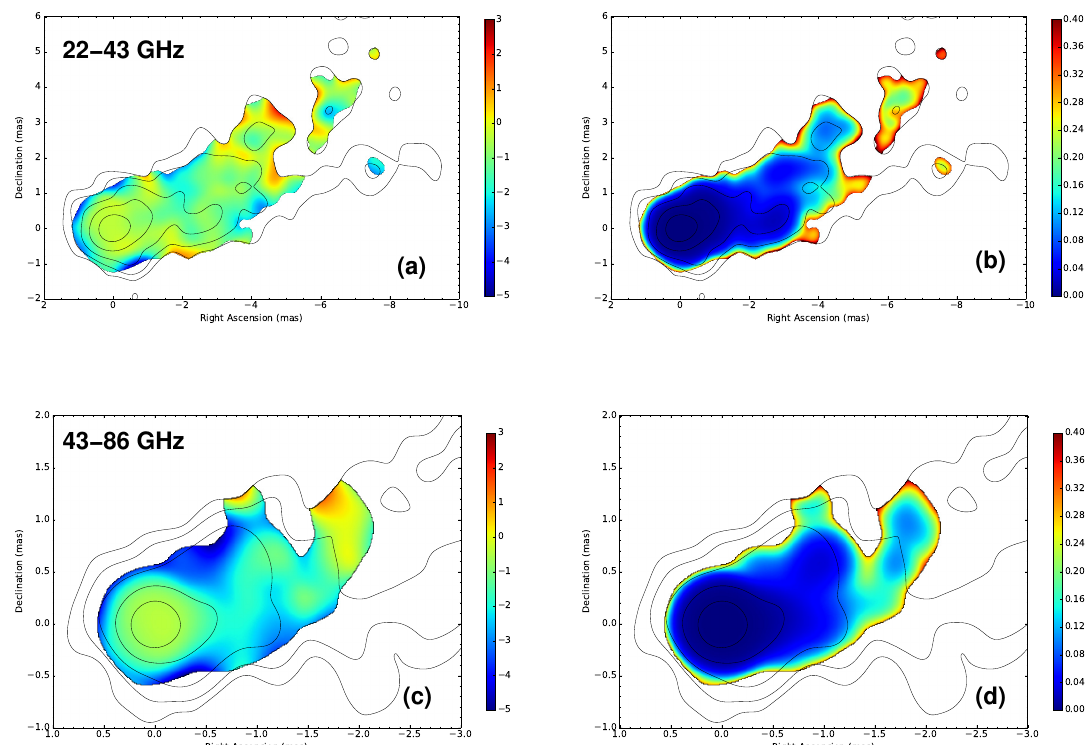
Figure 7. The pseudo-color maps of spectral-index distribution with color bars superimposed on the total intensity contour plots. Panel ( a ) shows 22–43 GHz spectral-index map superimposed on the contour plot of 22 GHz. Panel ( c ) shows the 43–86 GHz spectral-index map superimposed on the contour plot of 43 GHz. Their noise maps showing distribution of uncertainty are also presented in panel ( b ) and ( d )